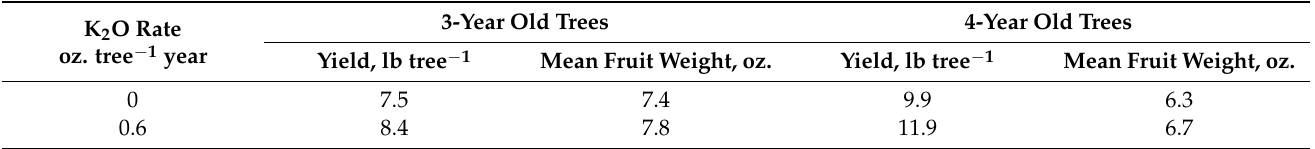
Table 2. Potassium fertigation affects fruit yield of 3- and 4-year old apple trees on dwarf rootstock [23]. 3-Year Old Trees 4-Year Old Trees K 2 O Rate oz. tree − 1 year Yield, lb tree − 1 Mean Fruit Weight,